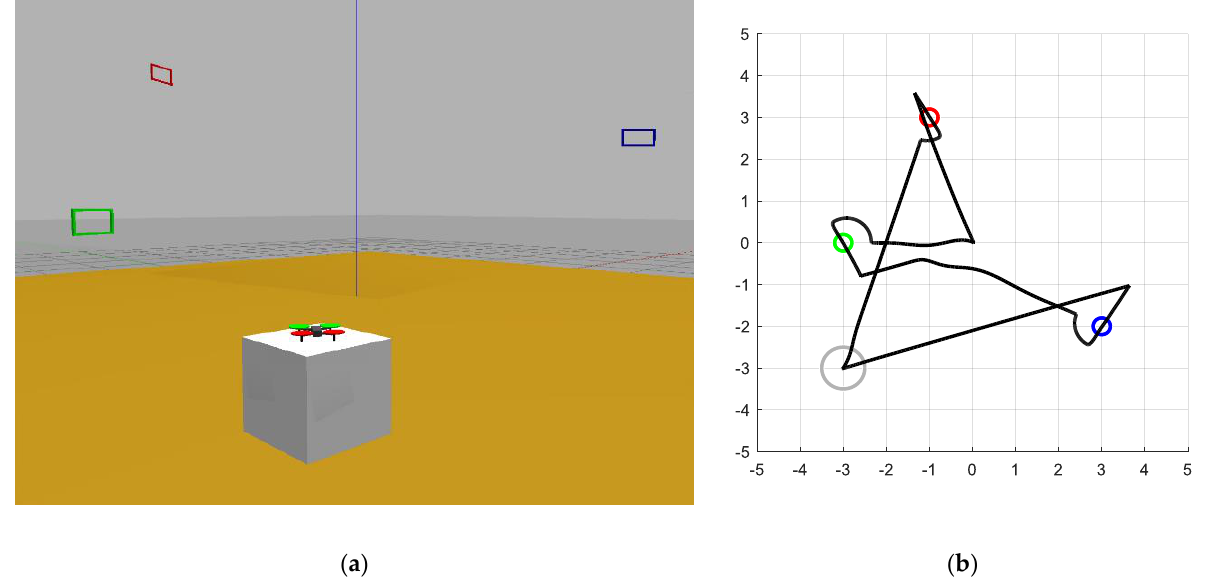
Figure 17. Test case 3: ( a ) simulated scenario (upper view); ( b ) path followed by the drone.